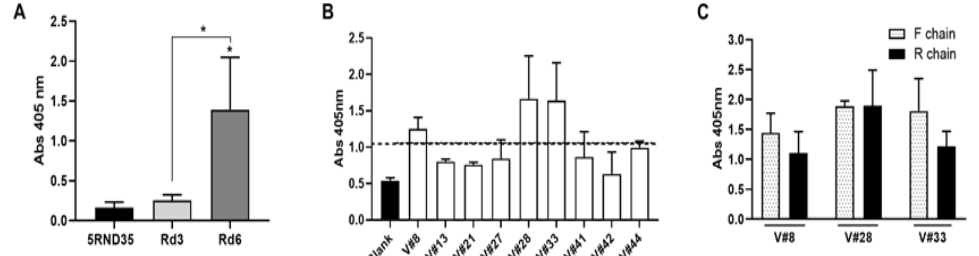
Figure 1. Selection and Identification of aptamers recognizing VRK1 protein. ( A ) VRK1 binding of round 3 (Rd3), round 6 (Rd6) population and RND35 initial pool by ELONA as described in the Materials and Methods Section. Recombinant protein VRK1 (200 ng/well; 4.3 pmol/well) was incubated with digoxigenin-labeled Rd3 or Rd6 aptamer population or digoxigenin-labeled RND35 at 2 ng/µL (80 nM). The graph represents the mean ± SEM of 3 independent experiments (* p < 0.05). ( B ) ELONA assay with F and R-digoxigenin-labeled individual aptamers was performed as in (A). The dotted line indicates the double of blank. ( C ) The chain F or R of the selected aptamers apVRK8 (V#8), apVRK28 (V#28) and apVRK33 (V#33) were labeled with digoxigenin and ELONA assay performed as above using the aptamers at a concentration of 1 ng/µL (40 nM). The graphs represent the mean ± SEM of 2 independent experiments.